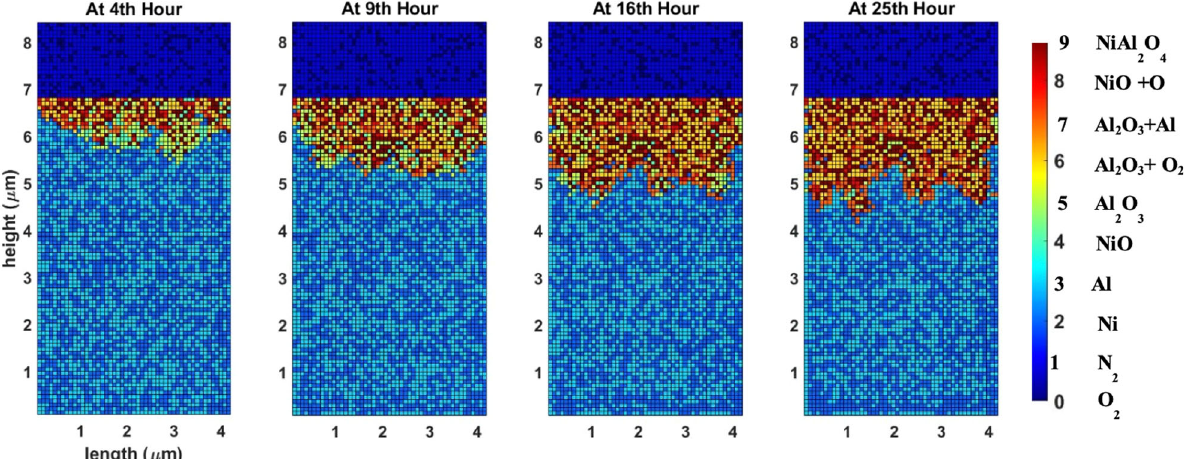
Fig. 4 Spatiotemporal evolution of the oxide scale morphology. The oxide scale is observed to grow rapidly during the initial state of oxidation, forming a protective oxide scale.